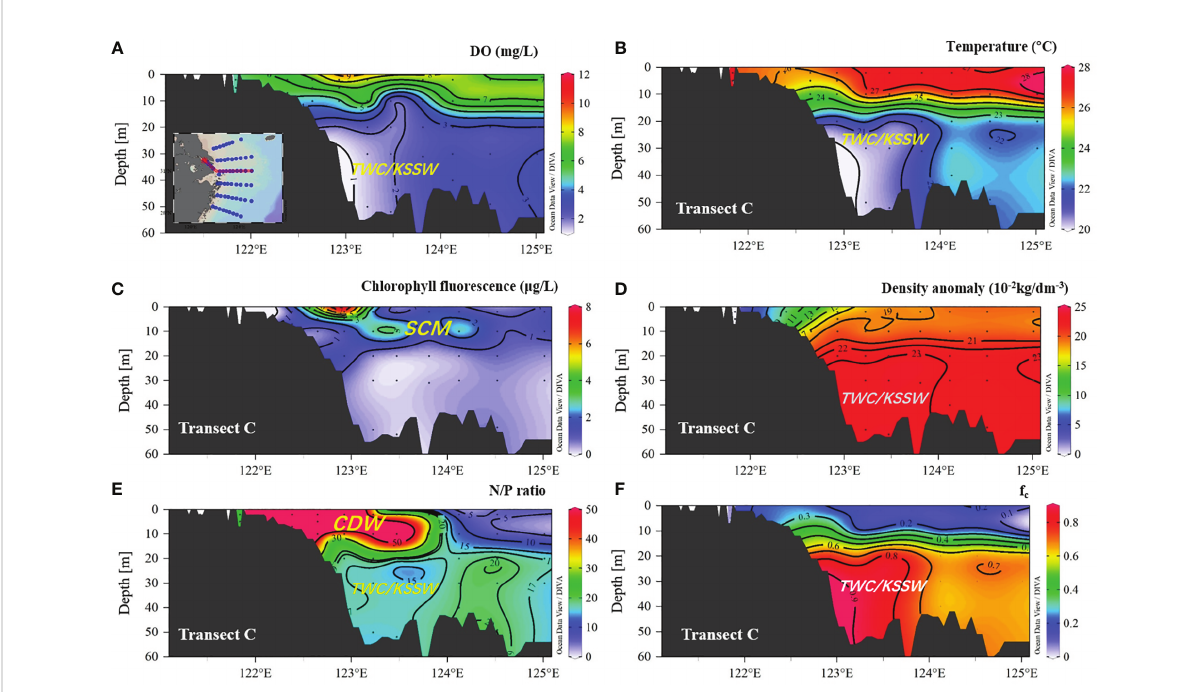
FIGURE 4 Distribution of DO, temperature, chlorophyll fl uorescence, density anomaly, N/P ratio, and fc (fraction of TWC/KSSW) in transect G – C. (A) DO (mg L − 1 ); (B) temperature; (C) chlorophyll fl uorescence; (D) density anomaly, (E) N/P ratio, and (F) fc (fraction of TWC/KSSW). CDW, Changjiang diluted water; SCM, subsurface chlorophyll a maximum; TWC/KSSW, Taiwan warm current and Kuroshio subsurface water.